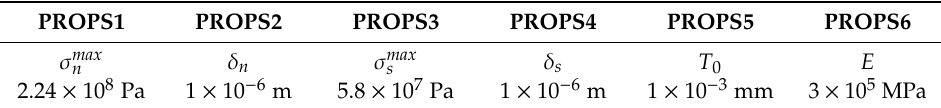
Table 5. Material parameters matrix.